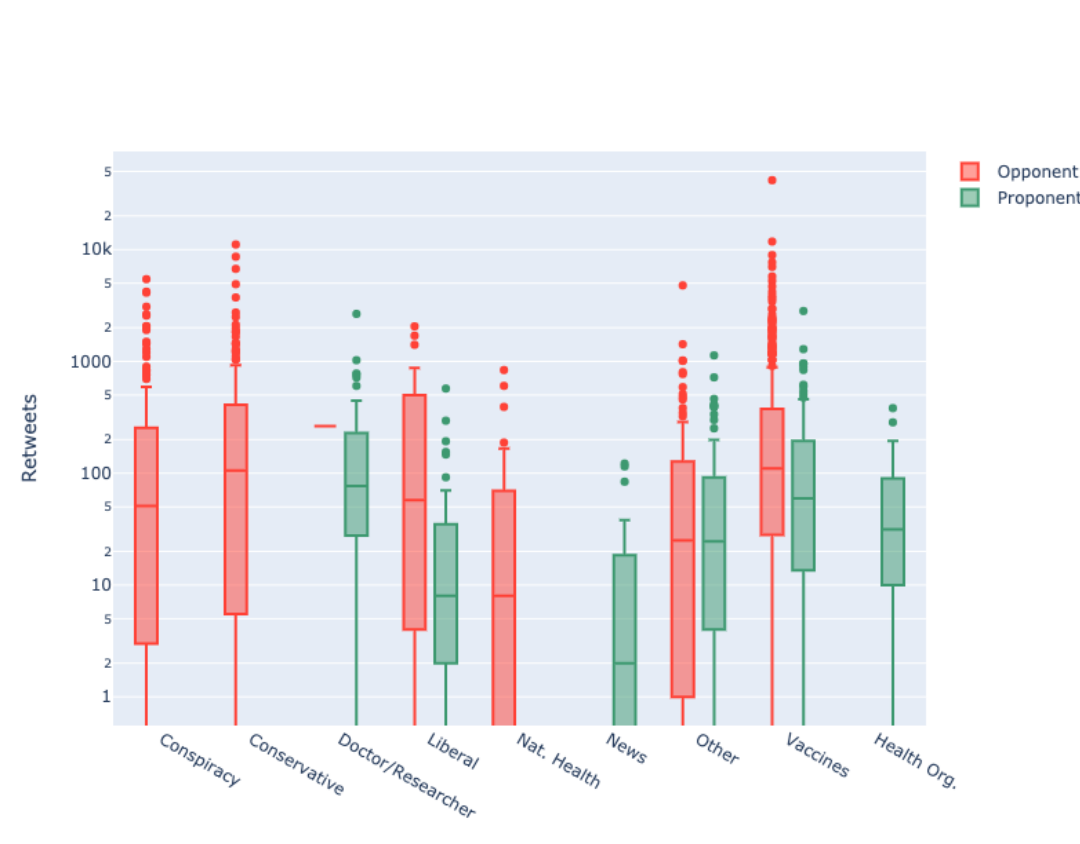
Figure 2. Botometer scores by sub community . Boxplots represent distributions of scores, with dots representing outliers. Scores > 0.43 were considered likely bots. Only news accounts appeared to have a significant proportion of likely bots. For an interactive version, please visit: